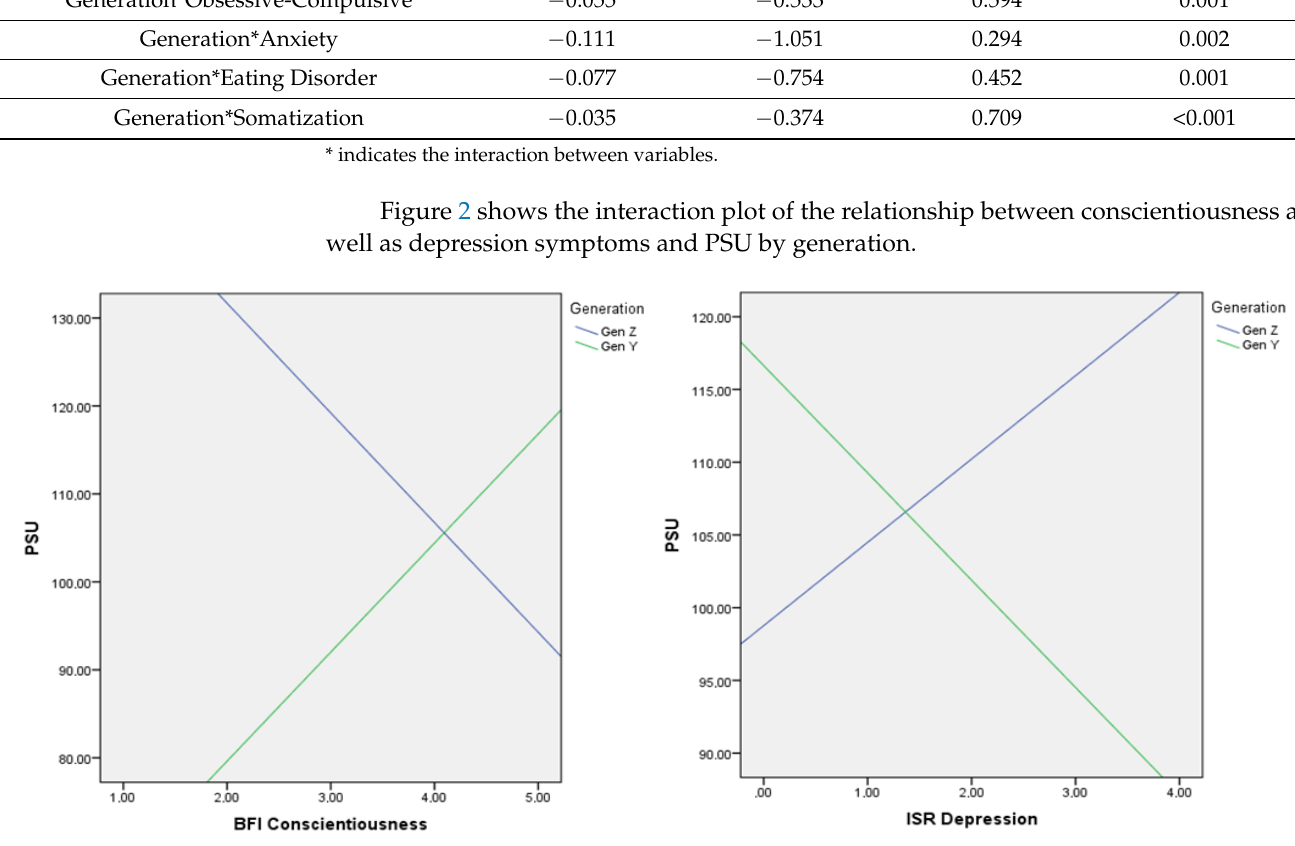
Figure 2. Interaction plot between conscientiousness and PSU and depression and PSU for Generation Y and Generation Z.